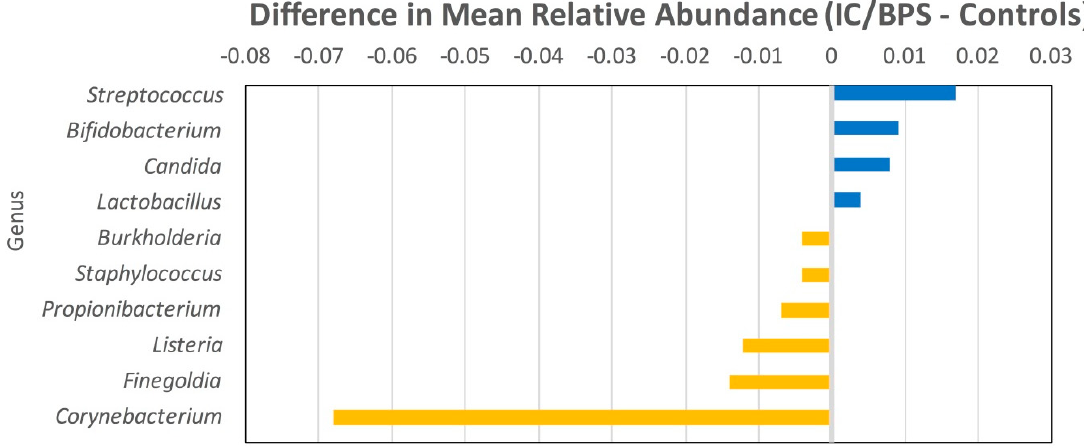
Figure 3. Differences in mean relative abundance at the genus level (IC/BPS minus controls) Blue indicates more abundant among UCPPS. Yellow is more abundant among controls.